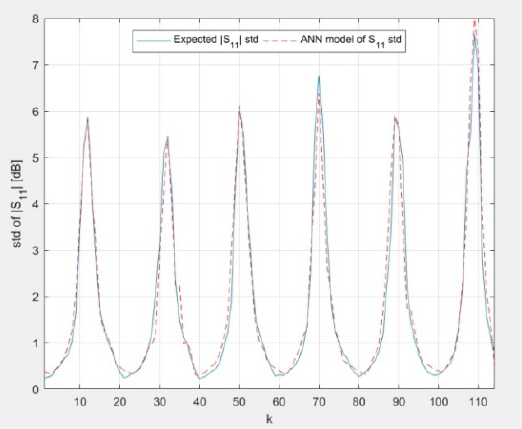
Figure 17. The expected and modeled standard deviation of | S 11 | of an ordinary patch antenna for the range of the first set of testing data.